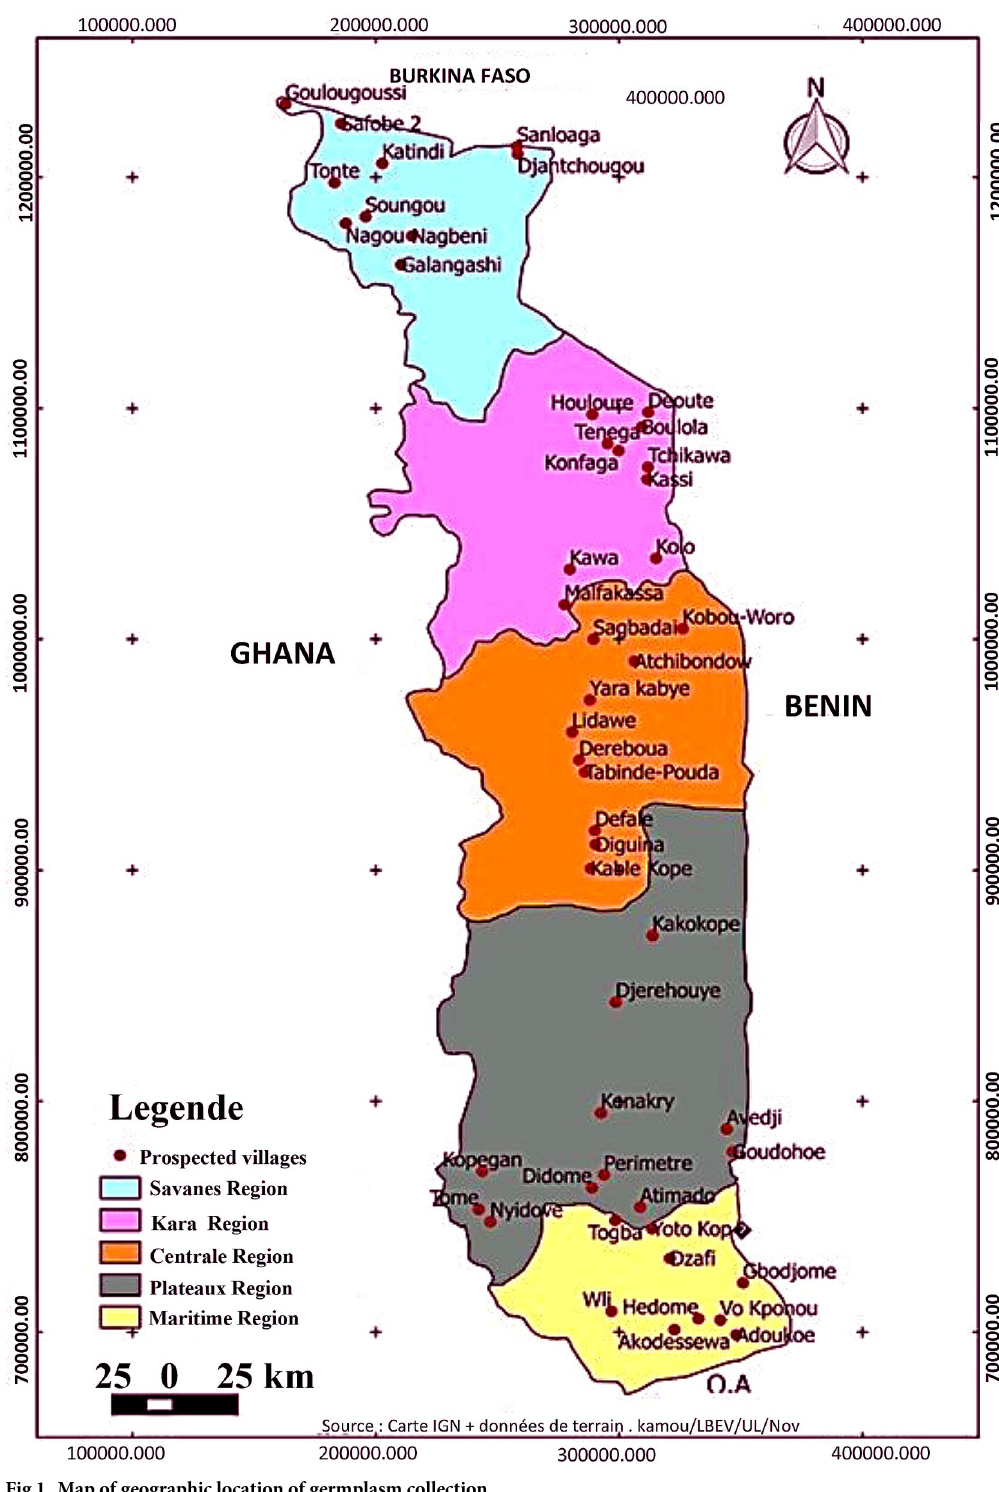
Fig 1. Map of geographic location of germplasm collection.